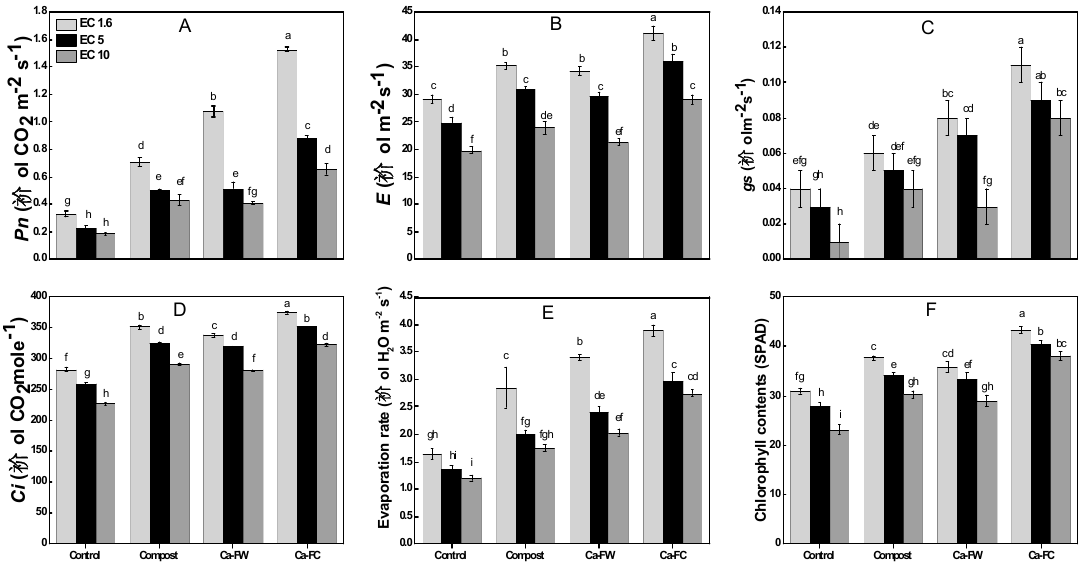
Figure 2. Effect of compost, Ca-FW, and Ca-FC on physiological parameters of maize ( Zea mays L.) under saline–sodic soil conditions. (Note: Ca-FW = calcium based fertilizer industry waste; Ca-FC = calcium-fortified compost; EC = electrical conductivity. Quantities sharing similar letters are statistically different from each other at p ≤ 0.05. Pn = photosynthetic rate; E = transpiration rate; gs = stomatal conductance; Ci = internal CO 2 concentration; SPAD = Soil Plant Analysis Development chlorophyll meter).